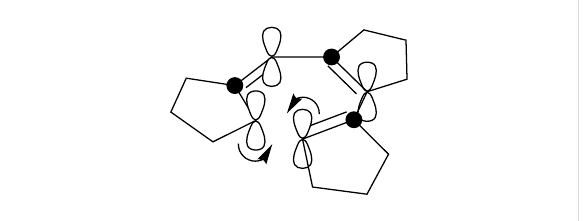
Figure 2: A possible mechanism for the trans -position of the methyne hydrogens in the azepine ring: the electrocyclization proceeds via a conrotatory mechanism due to the antisymmetry of the HOMO.